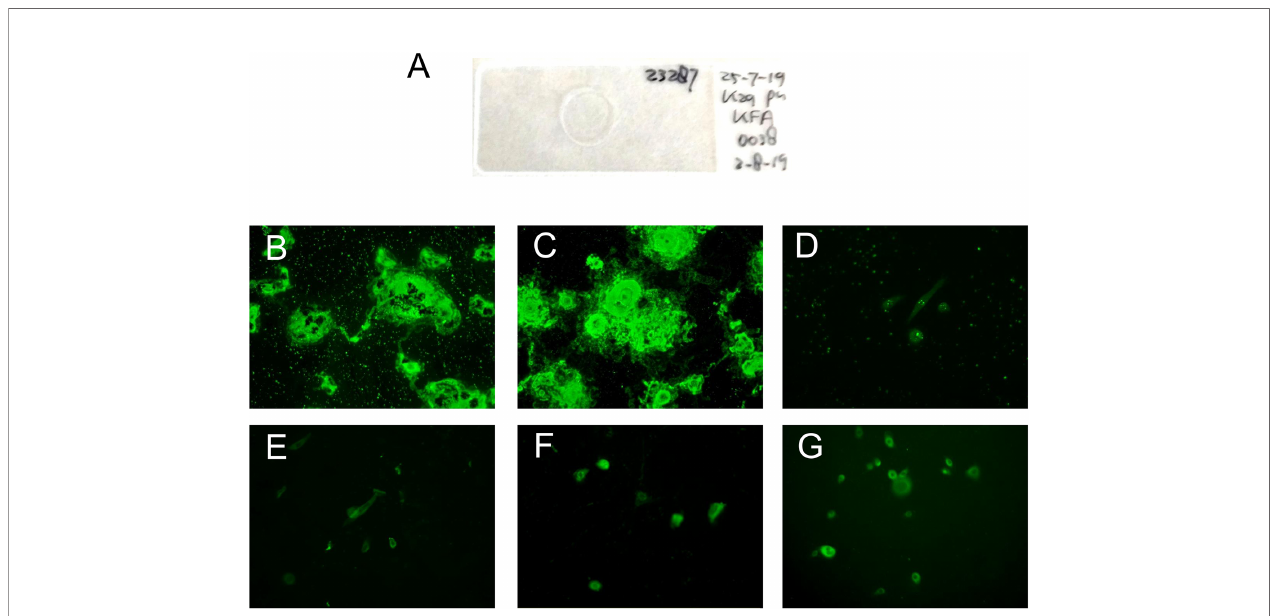
FIGURE 2 | Representative pictures of the indirect immuno fl uorescence-based keratinocyte footprint assay. (A) Example of an incubation slide with normal human keratinocytes grown on a glass coverslip. (B, C) MMP patient serum IgG binds to deposited laminin 332 on air-dried coverslips. (D) Serum of a healthy blood donor. (E) Serum of a bullous pemphigoid patient. (F) Serum of an epidermolysis bullosa acquisita patient. (G) Serum of an anti-p200 pemphigoid